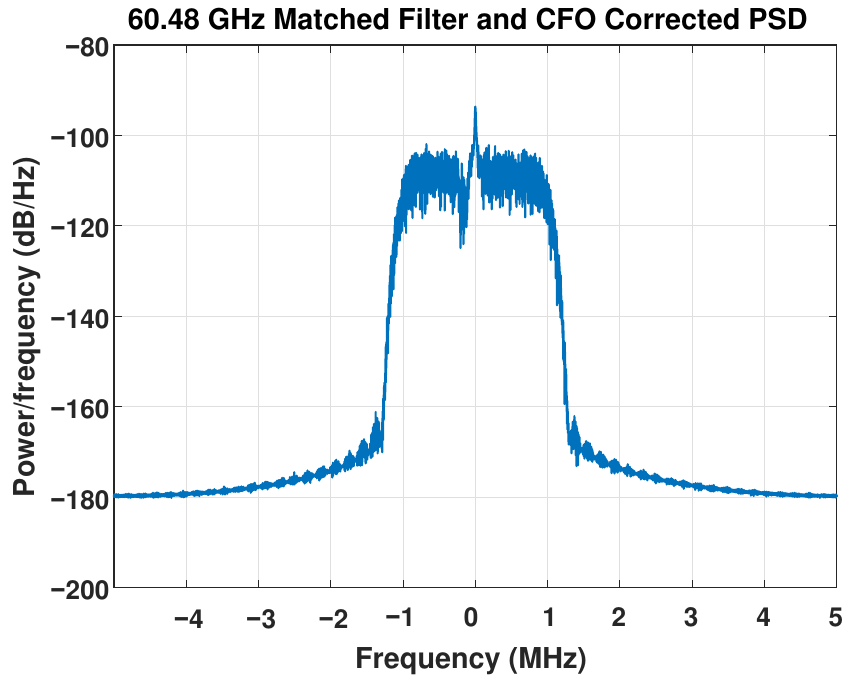
Figure 16. Snapshot of the over-the-air, received power spectral density in the WiGig Channel 2 band at 60.48 GHz after matched filtering and CFO